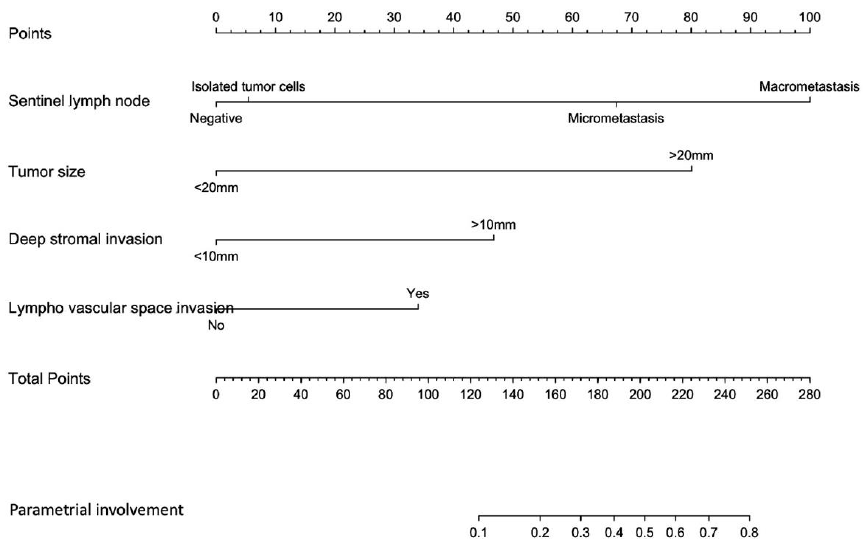
Figure 2. Nomogram predicting the likelihood of a parametrial involvement in patients with early stage cervical cancer. The probability of a parametrial involvement is calculated by drawing a line to the corresponding point on the axis for each of the following variables: tumor size; sentinel lymph node; deep stromal invasion; lympho-vascular space invasion. The points accumulated by the covariates are summed up and correspond to the “total points”. Next, a vertical line is projected from the total points line to the predicted probability bottom scale to obtain the individual probability of a parametrial invasion.